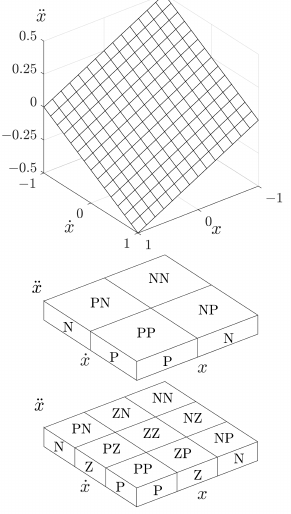
Figure 11. Second-order inference map.